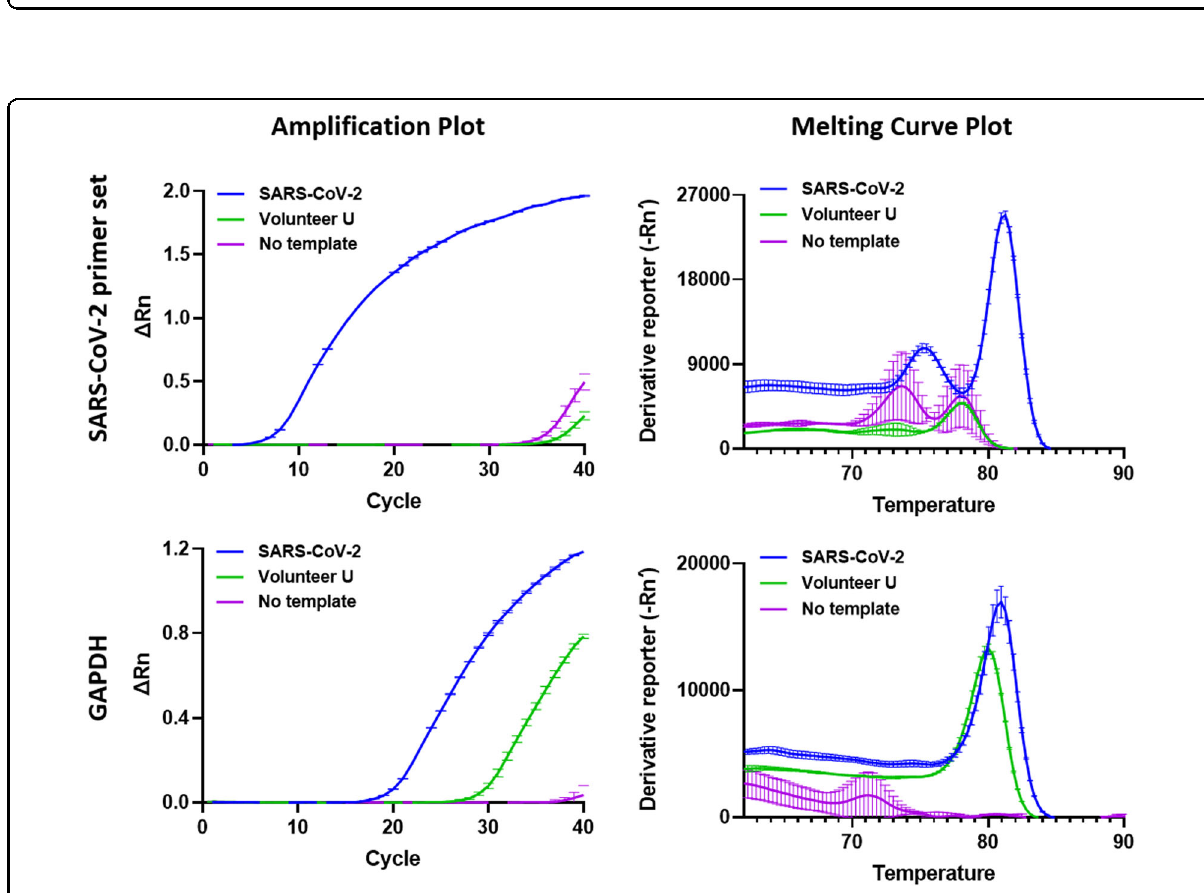
Fig. 5 Development of a multiplex real-time PCR detection protocol for SARS-CoV-2. Multiplex real-time PCR results for the SARS-CoV-2 primer sets SARS-CoV-2_IBS_E2, SARS-CoV-2_IBS_RdRP2, SARS-CoV-2_IBS_S2, and SARS-CoV-2_IBS_N1. The GAPDH primer set was used as the IPC primer set. The graphs on the left represent ampli fi cation plots. The graphs on the right represent melting curve plots. The fi nal concentration of the primer mix was 500 nM. The green curve is for the Volunteer U cDNA sample. The blue curve is for the SARS-CoV-2 cDNA. The purple curve is for the no- template condition. All data are represented as the mean ±